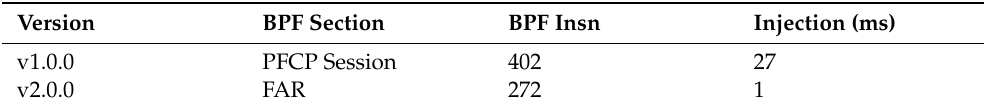
Table 2. Time spent to inject BPF program into the Linux kernel (JIT compiler phase) after receiving a PFCP Establishment Request message with only one